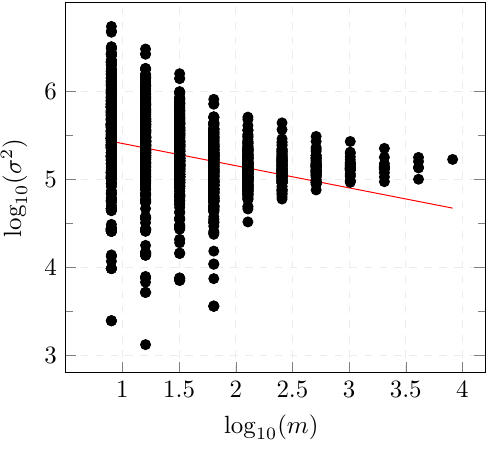
Figure 1. Variance-time